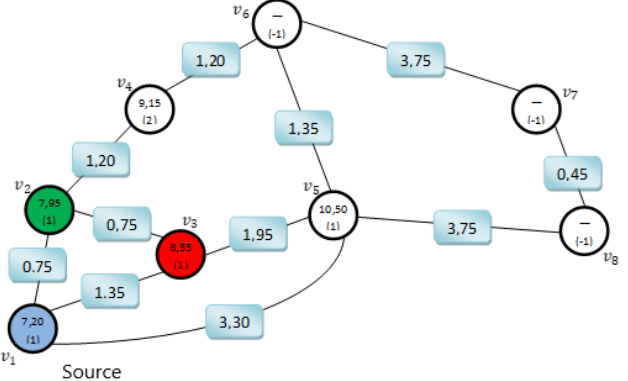
Figure 5. Finding the optimal path from peak 1—step 2.